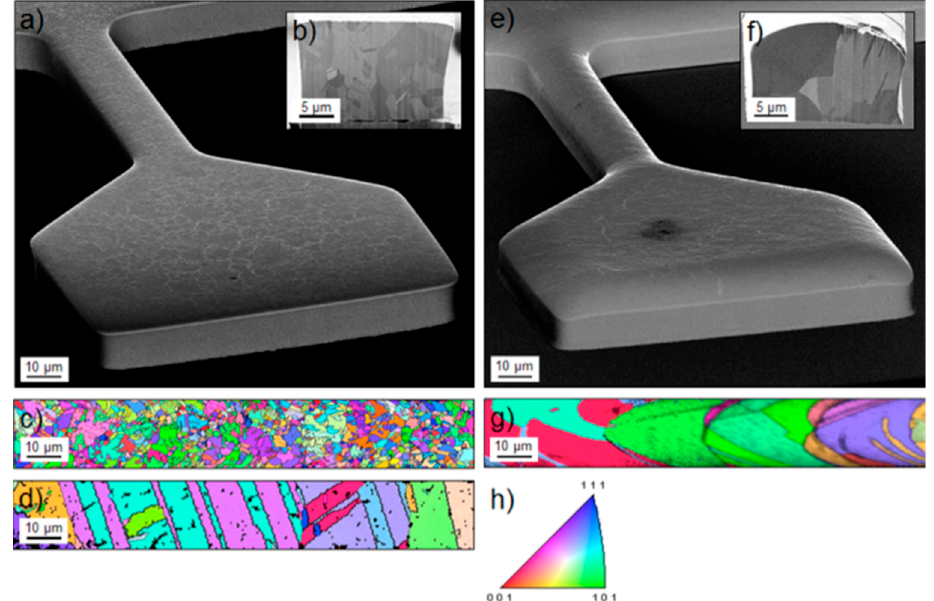
Figure 5. EBSD/SEM images of the surface and cross ‐ section of the tensile ‐ samples. ( a – c ) Sample type A, ( d ) sample type A annealed at 1073 K for 5 h, ( e – g ) sample type B and ( h ) colour code of the inverse pole figure corresponding to the grain orientations. Reprinted from A. Wimmer, M. Smolka, W. Heinz, T. Detzel, W. Robl, C. Motz, V. Eyert, E. Wimmer, F. Jahnel, R. Treichler and G. Dehm, “Temperature dependent transition of intragranular plastic to intergranular brittle failure in electrodeposited Cu micro ‐ tensile samples,” Mater. Sci. Eng. A 618 , 398 (2014), with permission from Elsevier.